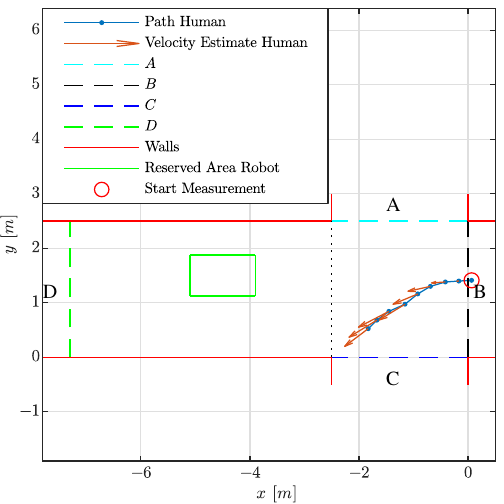
Figure 9. Situation of Table 3 where a person moves from area B to area C and the hypothesis is not correctly